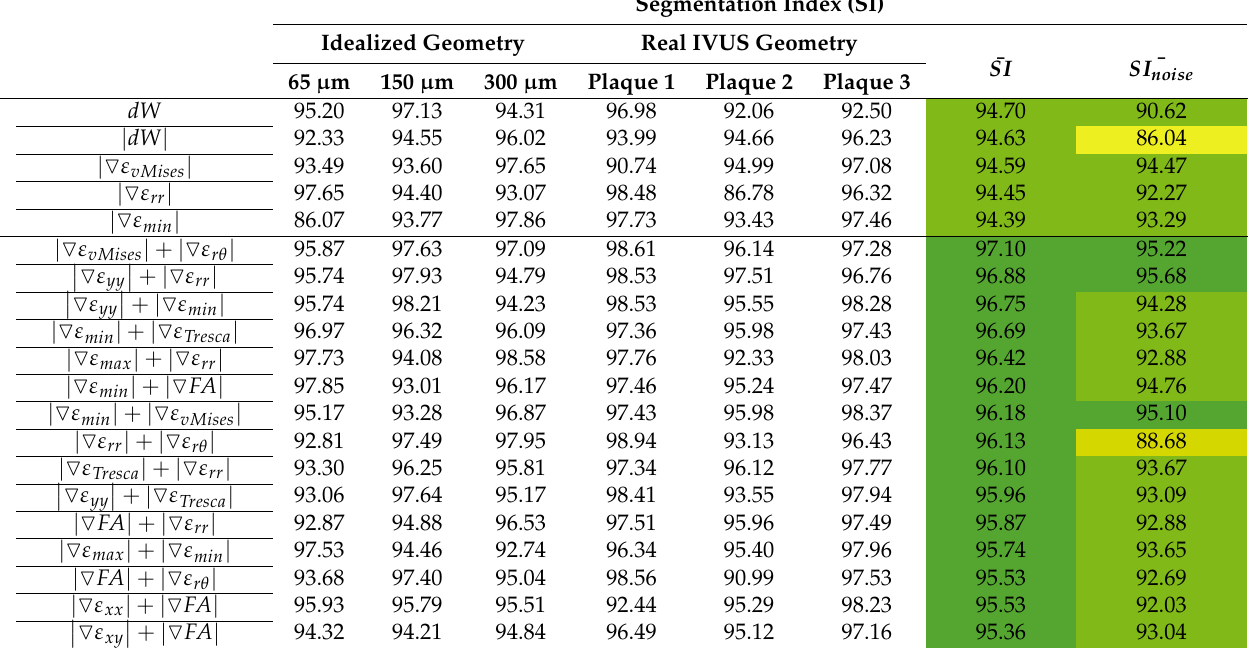
Table 2. Summary of the results for the best five single SGVs and fifteen SGV combinations for the lipid segmentation of all of the 105 possible combinations based on the results of the idealized and IVUS geometries with FE strains. The SGVs with the SI value in dark green mean a perfect segmentation; light green stands for good segmentations; yellow for SGV indicates some problems in segmenting the fibrous cap or the lipid area. ¯ SI and ¯ SInoise represent the mean SI value without and with noise, respectively.